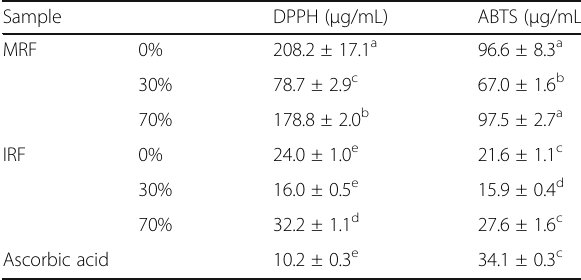
Table 1 IC 50 value of antioxidant activity from 0, 30 and 70% ethanol extracts of mature and immature fruit of Rubus